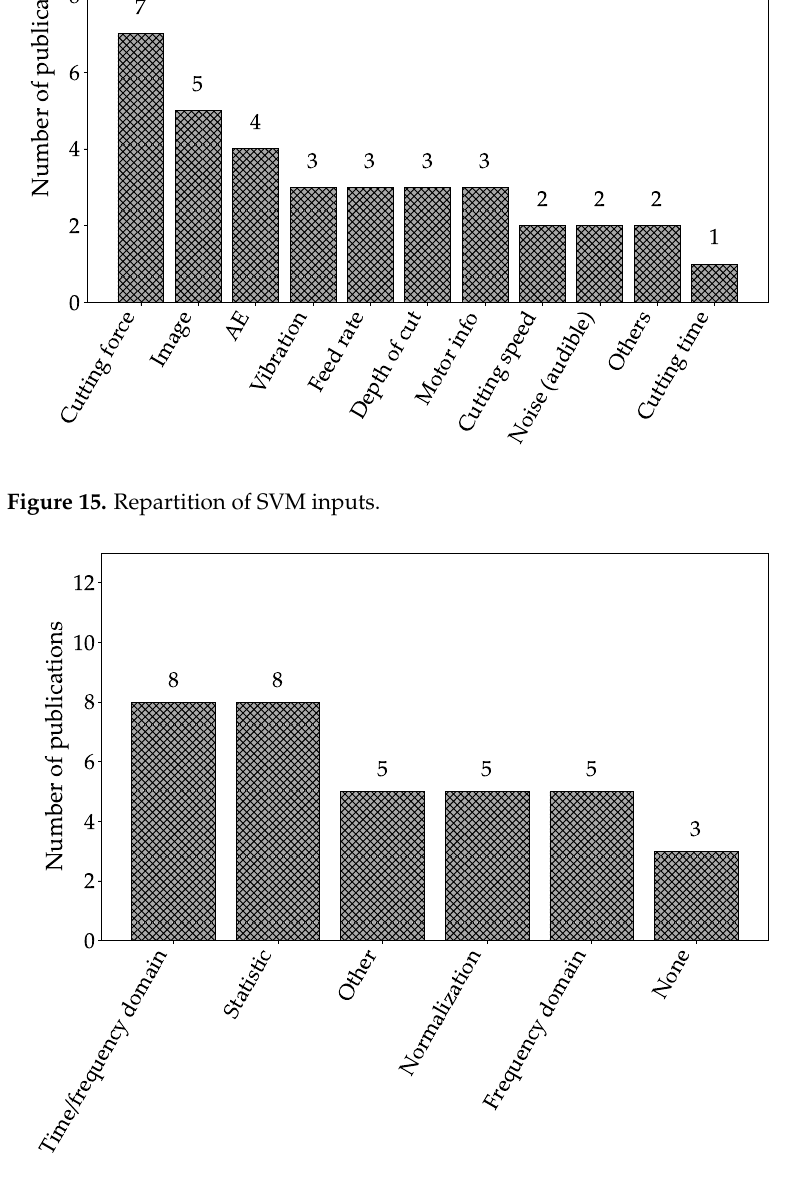
Figure 16. Repartition of SVM